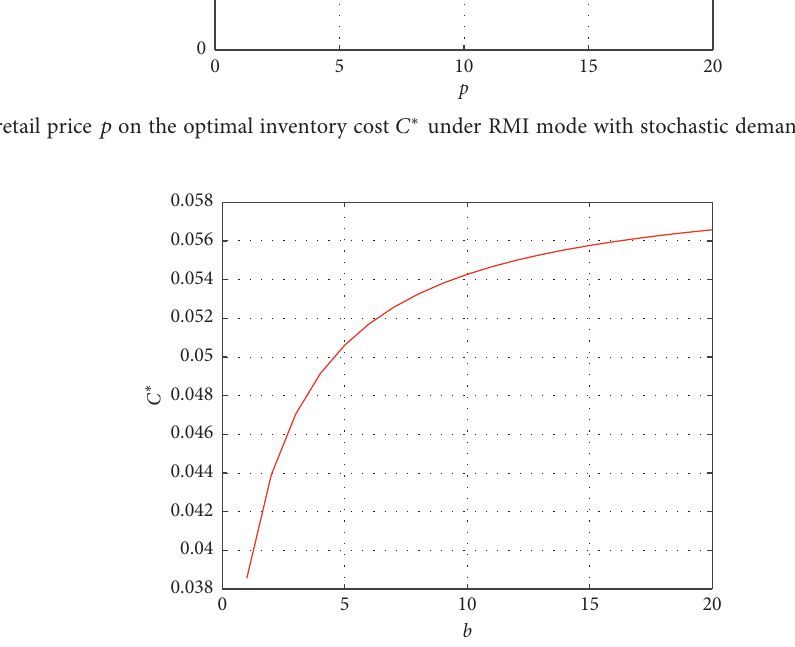
C ∗ under RMI mode with stochastic demand in the water supply